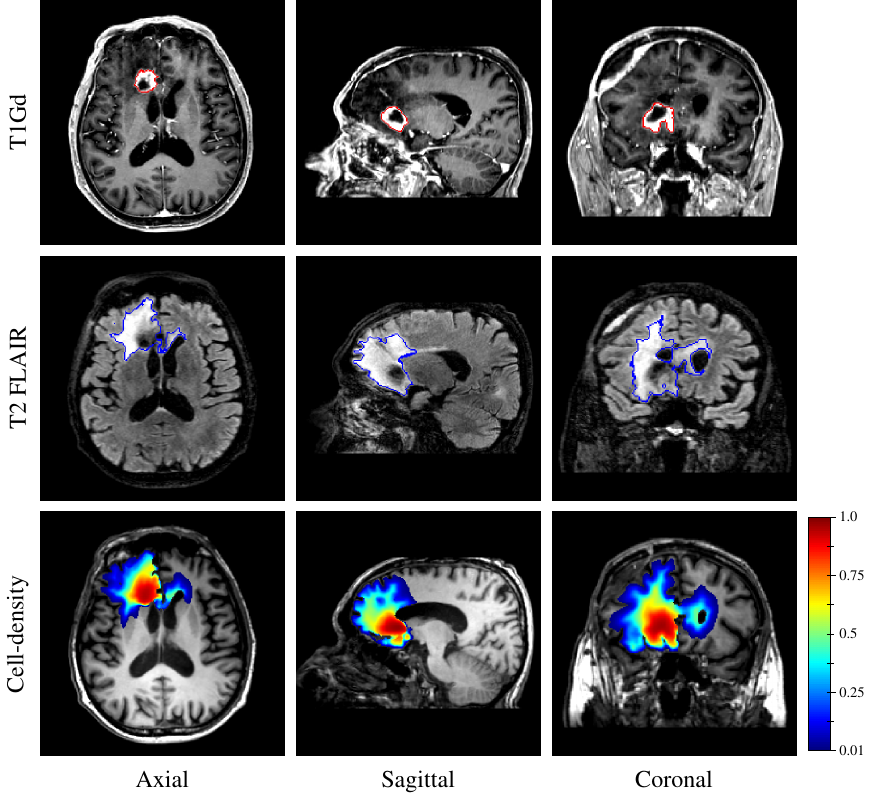
Figure 12. T1Gd image (1st row), T2 FLAIR image (2nd row), and estimated three-dimensional tumor cell-density distribution using the first network (3rd row) for an IDH-wildtype glioblastoma patient in axial (1st column), sagittal (2nd column), and coronal (3rd column) planes. The contours of the segmented enhancing core and peritumor vasogenic edema are superimposed in red on the T1Gd (1st row) and in blue on the T2 FLAIR (2nd row) images,